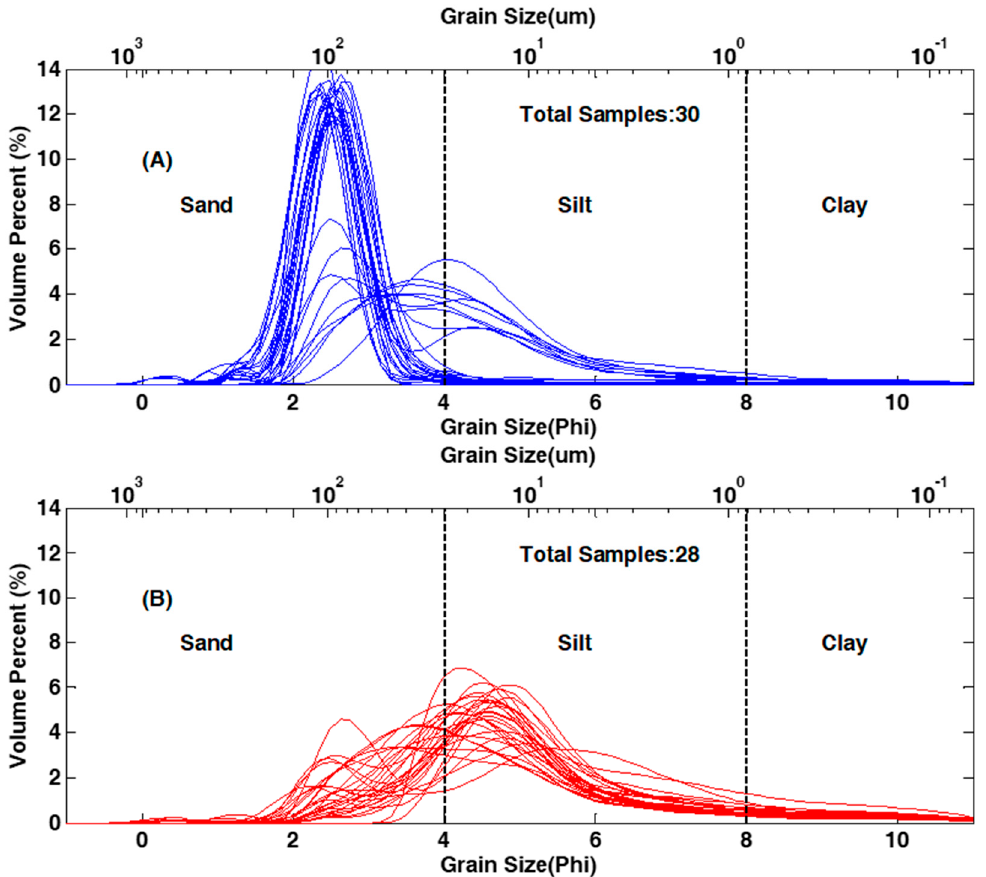
Figure 4. Grain size distributions of surficial sediment samples collected inside Caminada pit in August 2018 (see Figure 2B for grab sample locations). ( A ) Shows the grain size distribution of 30 sandy samples and ( B ) shows 28 muddy samples.